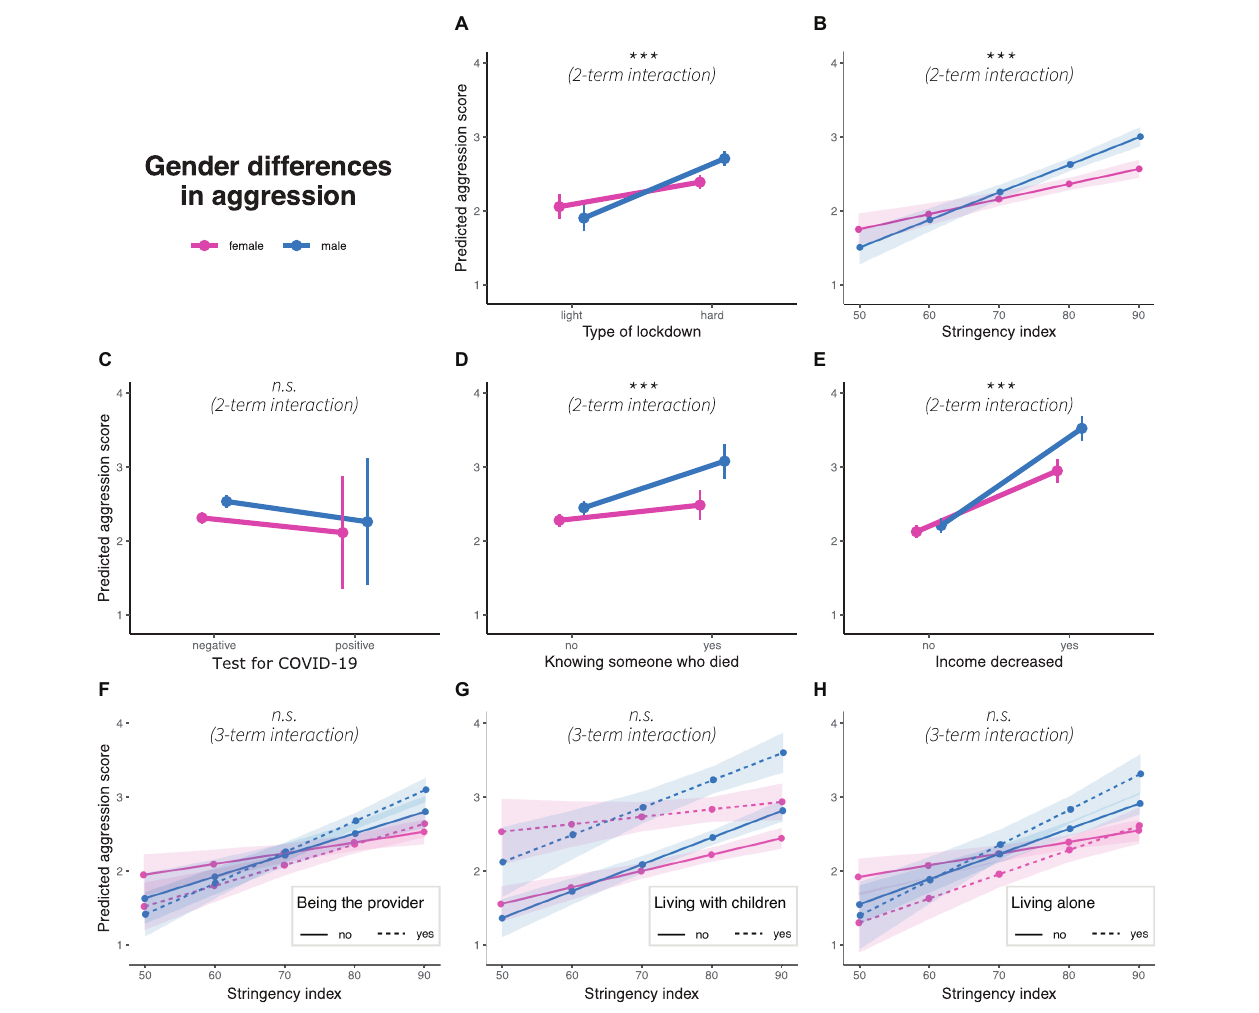
FIGURE 2 | Gender differences in predicted aggression scores concerning (A) type of lockdown, (B) stringency index, (C) test for COVID-19, (D) knowing someone who died due to pandemic, (E) income decrease, and interaction of stringency index with (F) being the main household provider, (G) living with children and (H) living alone. Colors represent gender, dots represent marginal means, error bars or ribbons represent 95% confidence intervals. Linetypes represent at the bottom additional interaction terms. Significance of interaction effects are shown in italics; n.s.: non-significance. *** p <